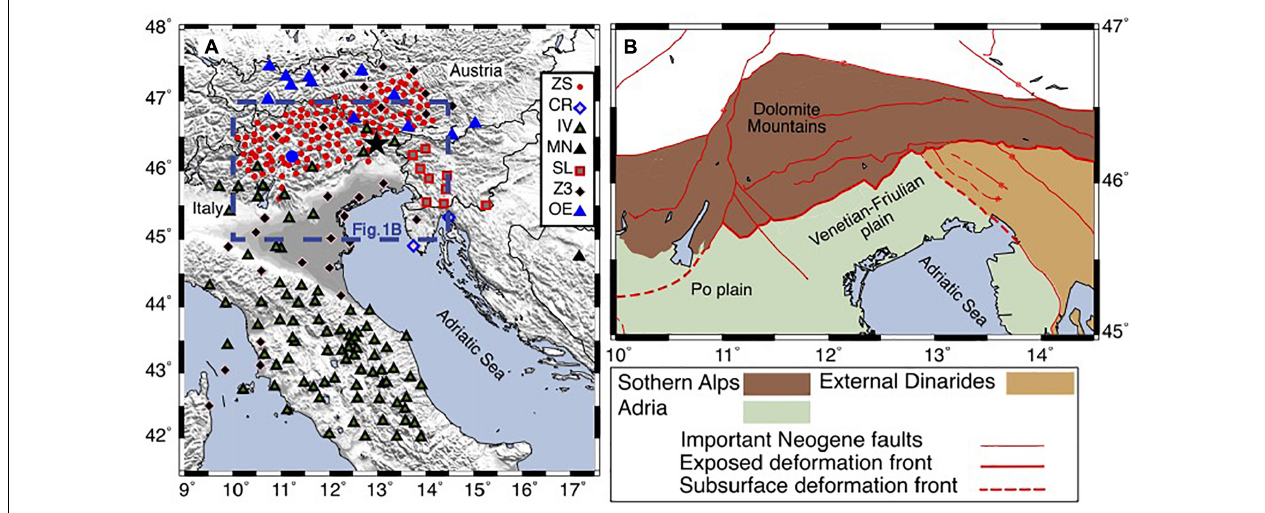
FIGURE 1 | (A) Map showing the seismic stations used in this study. The ZS, CR, SL, and MN stations are used for computation of correlograms in this study. The correlograms computed using up to 4 years of the recordings from the IV, OE, and Z3 stations are adopted from Nouibat et al. (2021). The blue circle shows the location of D024 station of the ZS network and location of the June 14, 2019, Mw 3.7 earthquake is shown by black star. (B) Map showing the major tectonic features in the study region modified from Schmid et al. (2004, 2008) and Handy et al. (2010). ZS–SWATH-D temporary network; CR–Croatian seismograph network; IV–Italian national seismic network; MN–Mediterranean very broadband seismographic network; SL–Seismic network of the republic of Slovenia; Z3–AlpArray Z3 network; OE–Austrian seismic